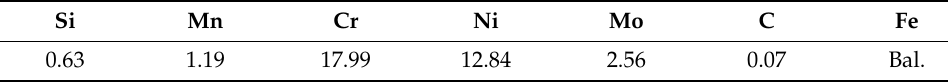
Table 1. Chemical composition of 316 stainless steel (wt.%).